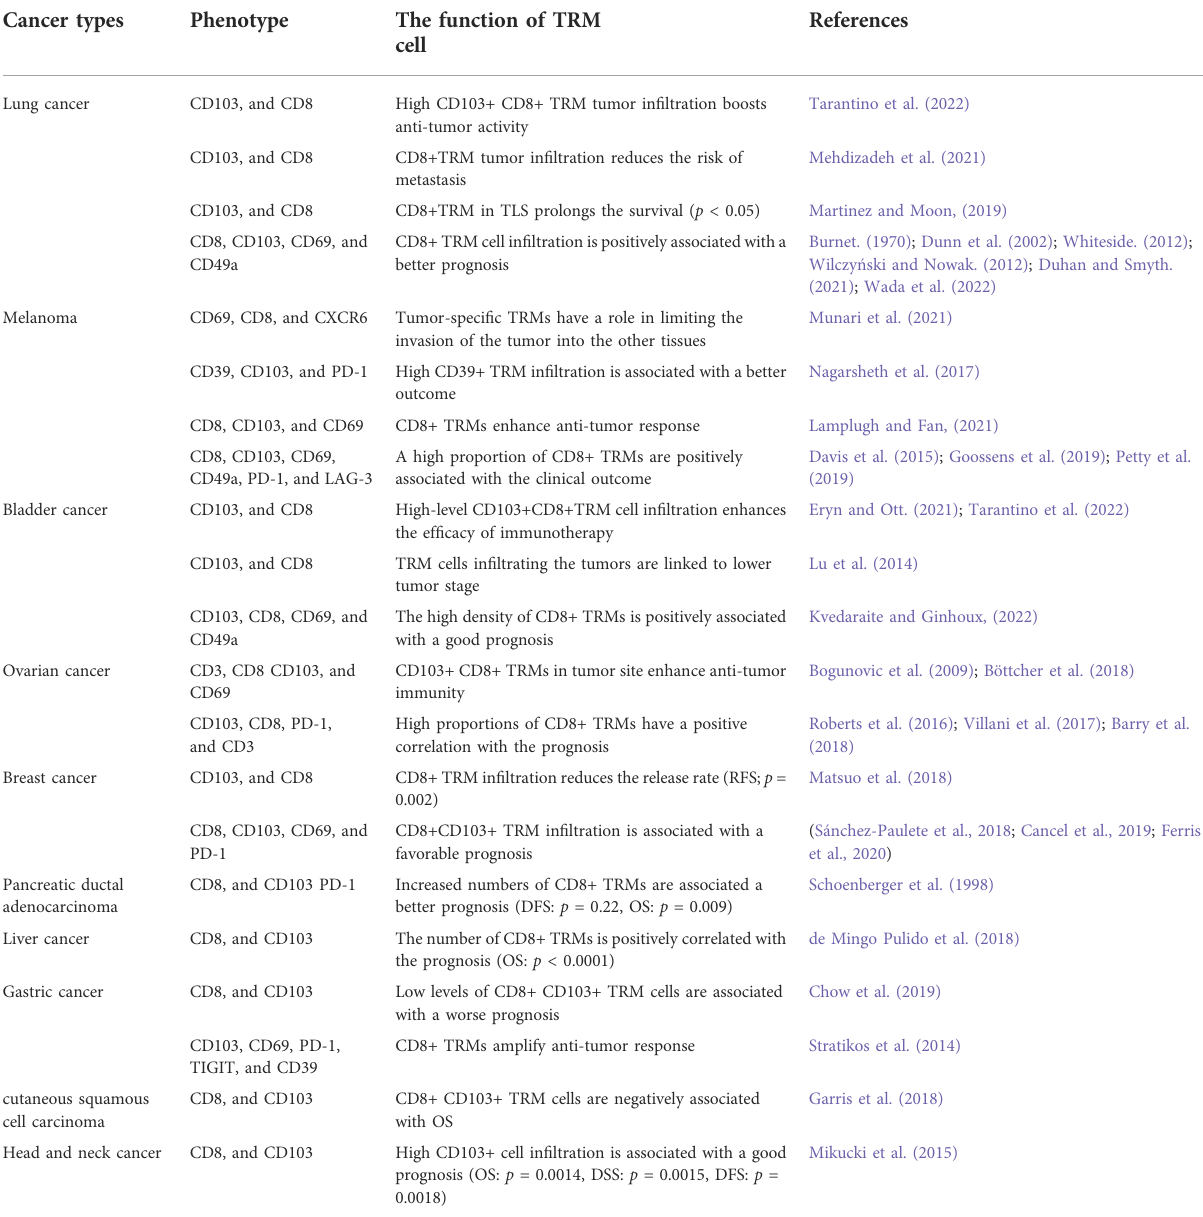
TABLE 1 The rRole of TRM cells in cancer